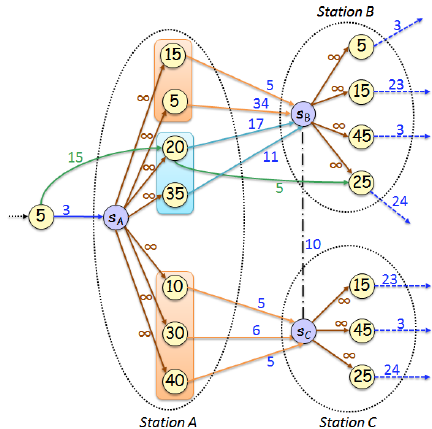
Figure 2. The MDTM graph corresponding to the DTM graph of Figure 1. Departure nodes grouping: light blue (brown) are train (bus) connections. The switch–switch arc (dotted black) introduces an unrestricted departure connection between the